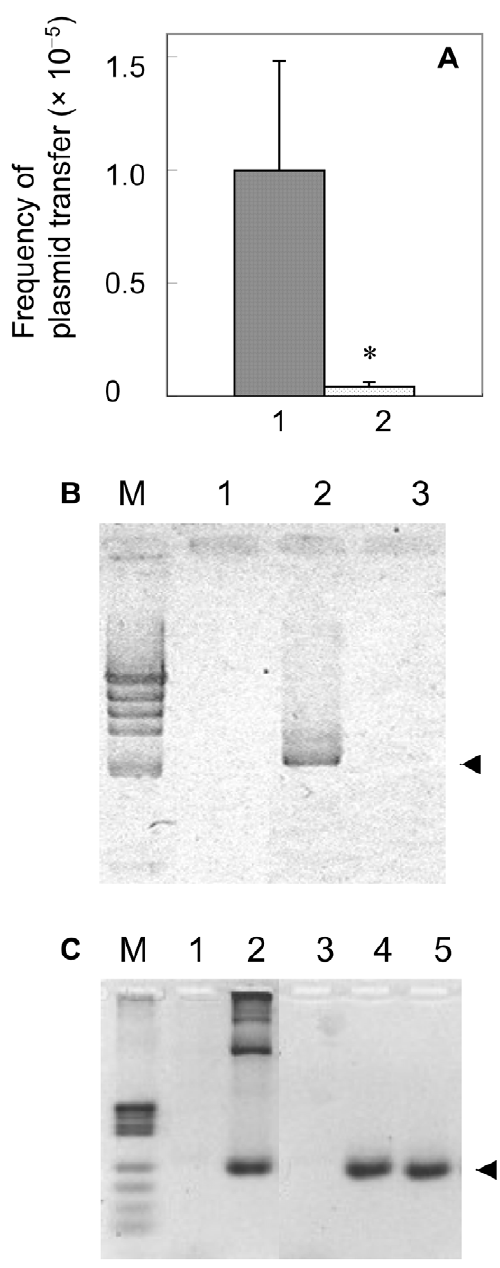
Figure 1. Effect of DNase I activity on lateral plasmid transfer and detection of plasmid in culture medium. Effect of DNase I activity on lateral plasmid transfer in cell-mixed culture (A, B), and detection of pHSG299 in culture medium (C). (A) Frequency of plasmid transfer [mean and standard deviation (S.D.); *: t -test: P , 0.05, n =5] in the absence (lane 1) and presence (lane 2) of DNase I (30 m g/mL) in a co-culture of MC4100 harbouring pHSG299 and CAG18439 in TSB. (B) Confirmation of workability of added DNase I in TSB culture.